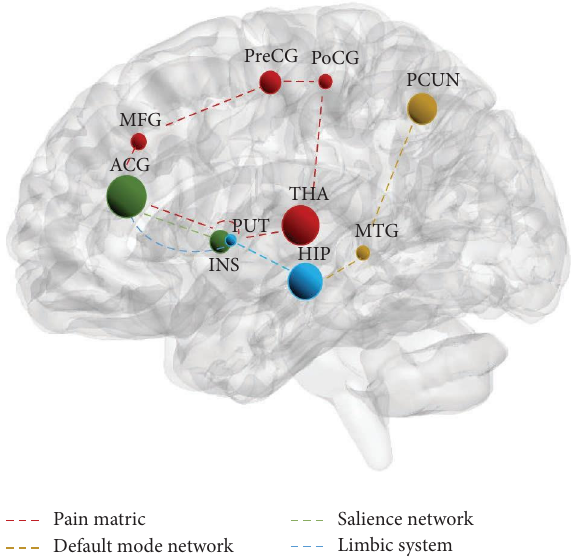
Figure 2: Main reported brain areas in patients with acupuncture- induced PD. Te size of the nodes indicates the frequency of the brain areas. Each color dashed lines indicate the diferent modu- lation pathways of acupuncture. ACG: anterior cingulate gyrus; HIP: hippocampus; THA: thalamus; PCun: precuneus; INS: insula; PreCG: precentral gyrus; MFG: middle frontal gyrus; POCG: postcentral gyrus; MidTG: middle temporal gyrus; PUT: